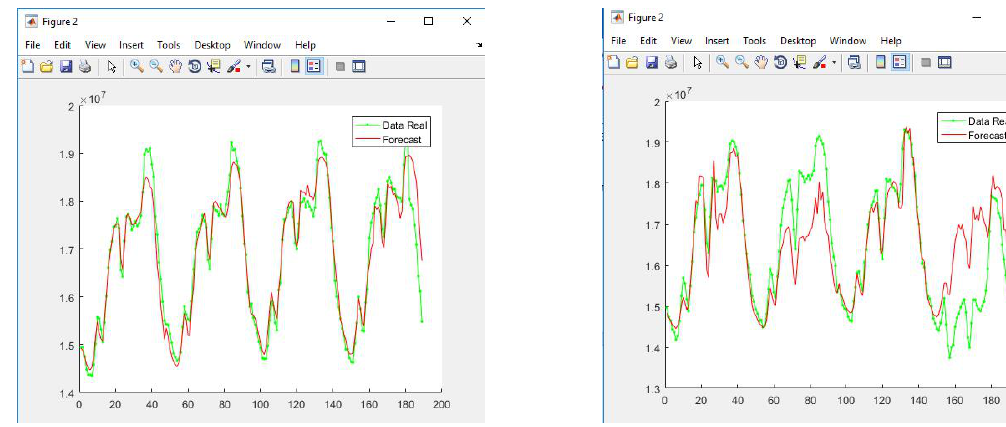
Fig. 9 Test result with JRNN for Friday Fig. 10 Test result with JRNN for Saturday